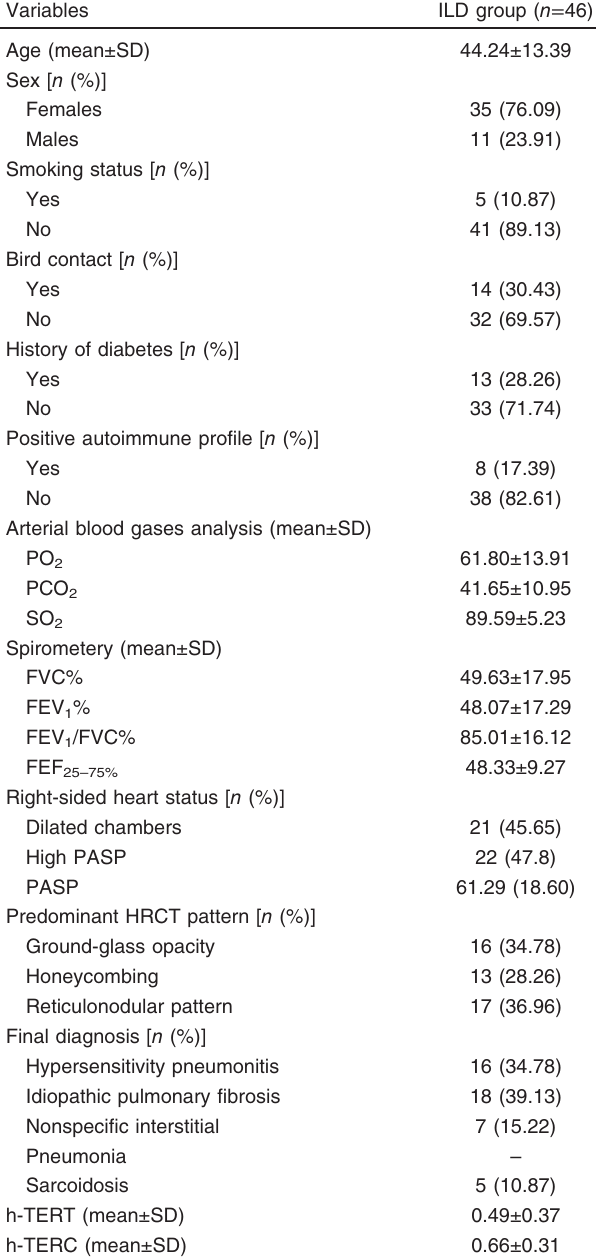
Table 1 Characteristics of interstitial lung disease